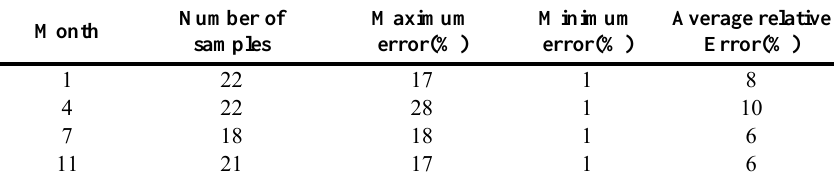
Table 3. Verification accuracy of relative soil moisture residuals models in representative months in